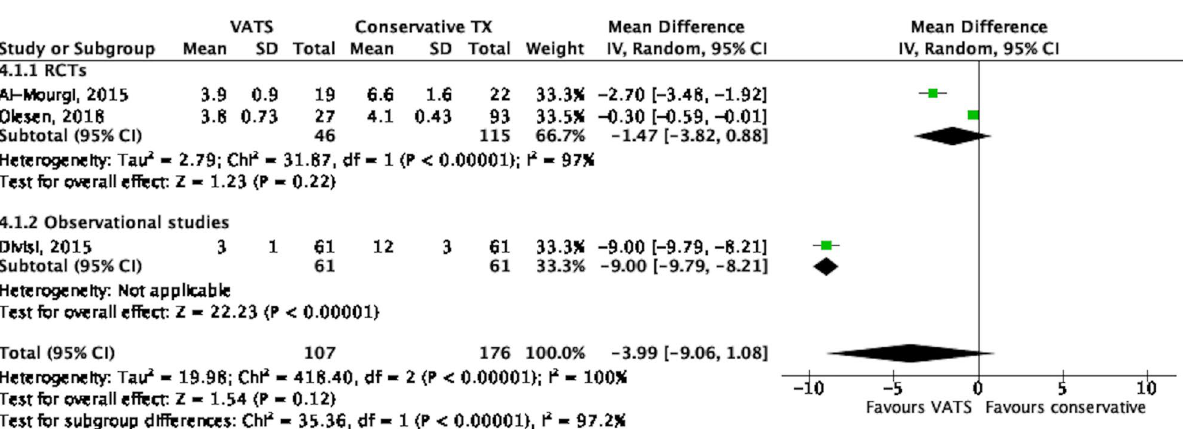
Figure 5. Forest plot of the comparison of drainage duration between VATS and conservative